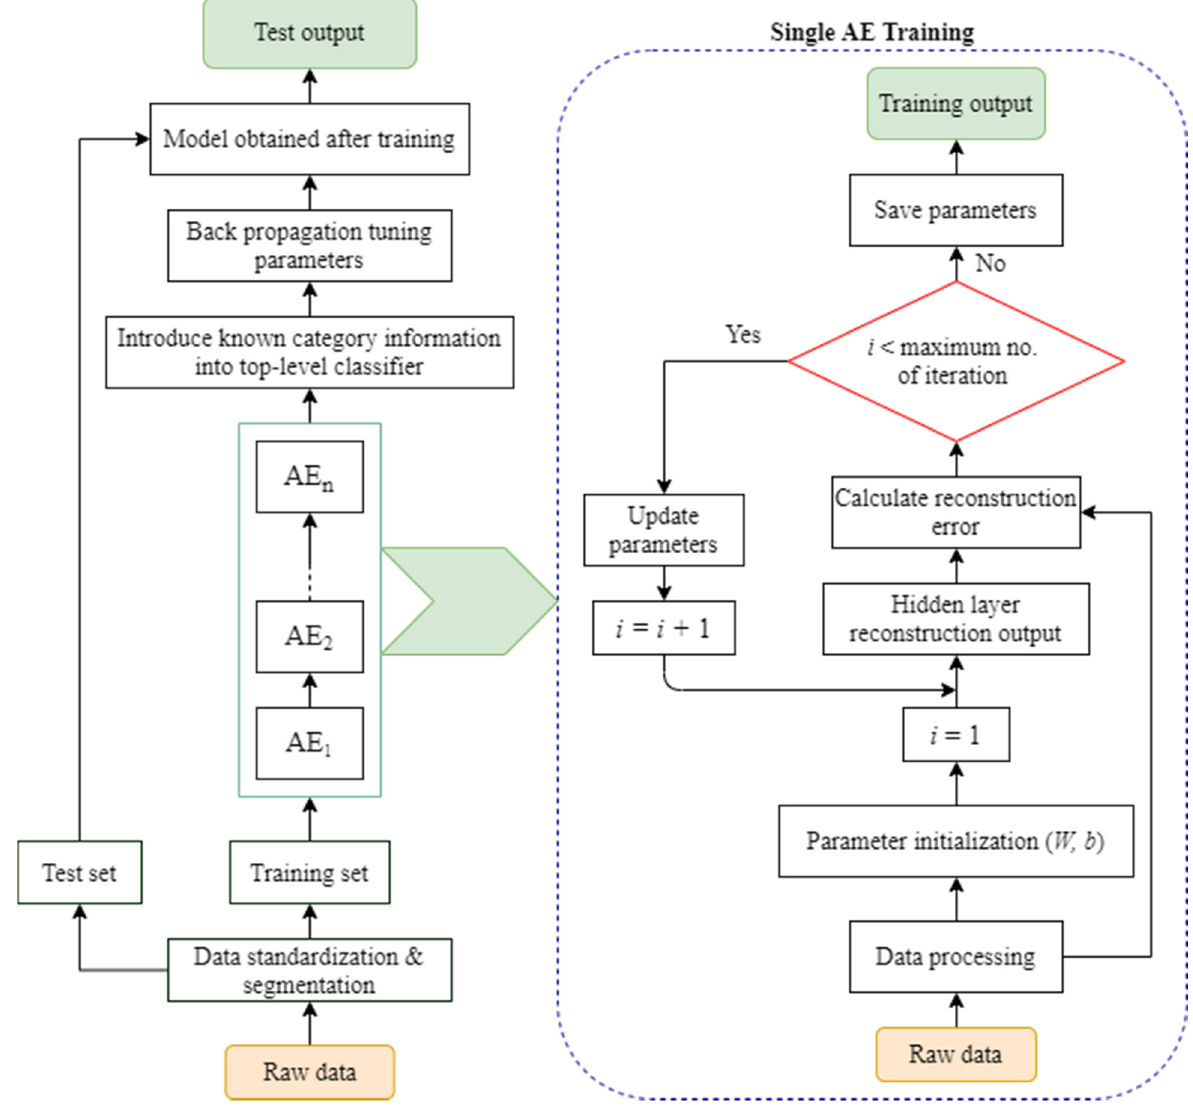
Figure 12. Fault diagnosis framework of stacked AE.